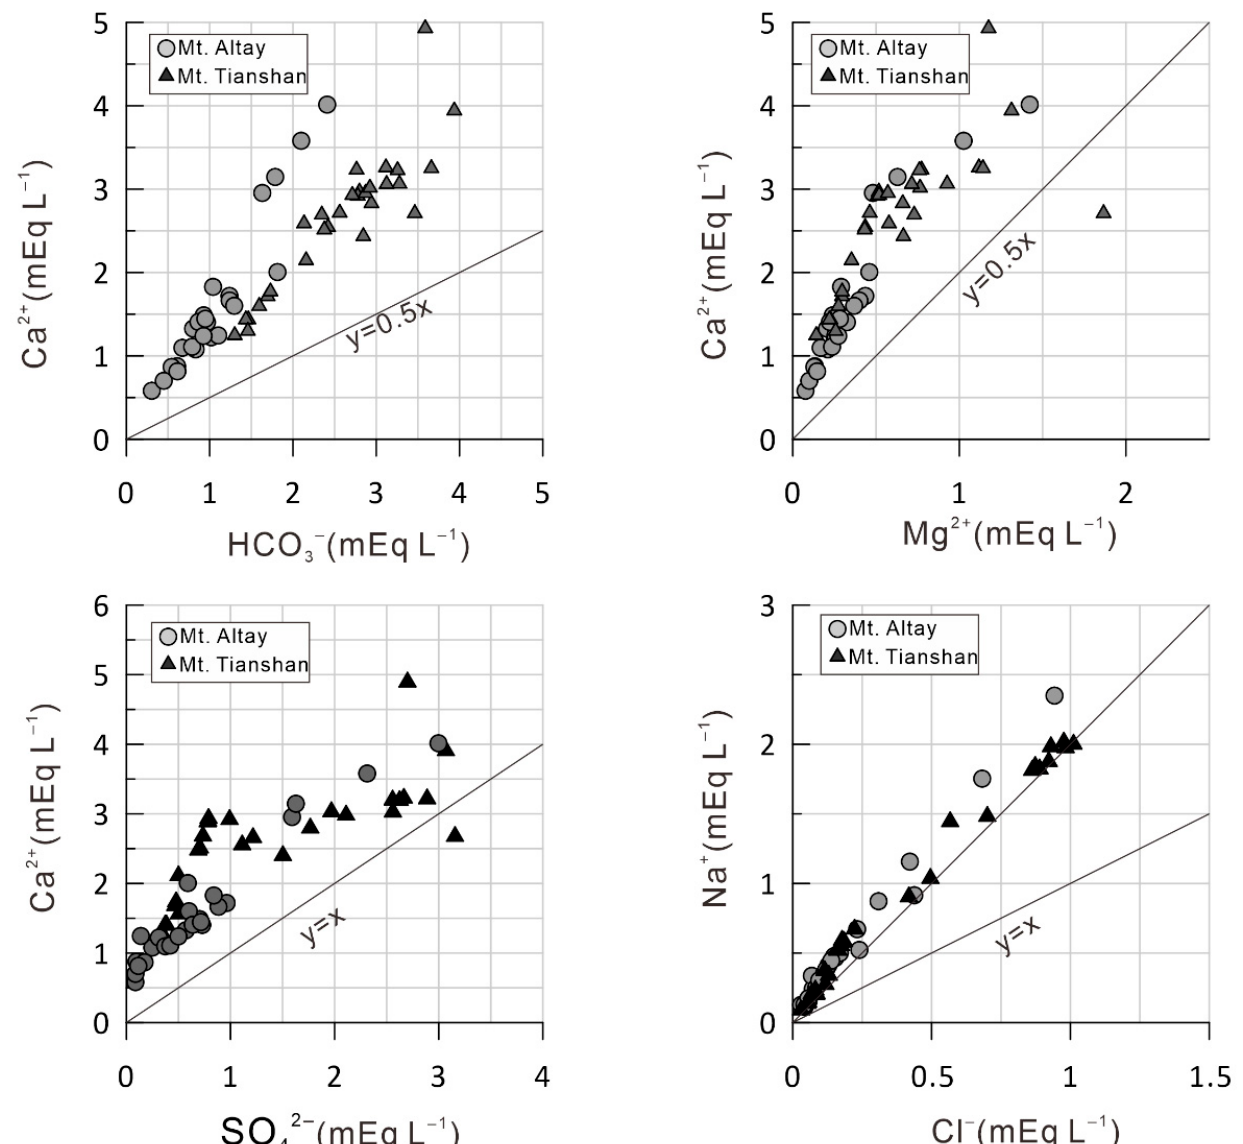
Figure 9. The relationship among the major ions of waters in the regions of the Tianshan and Altay Mts.